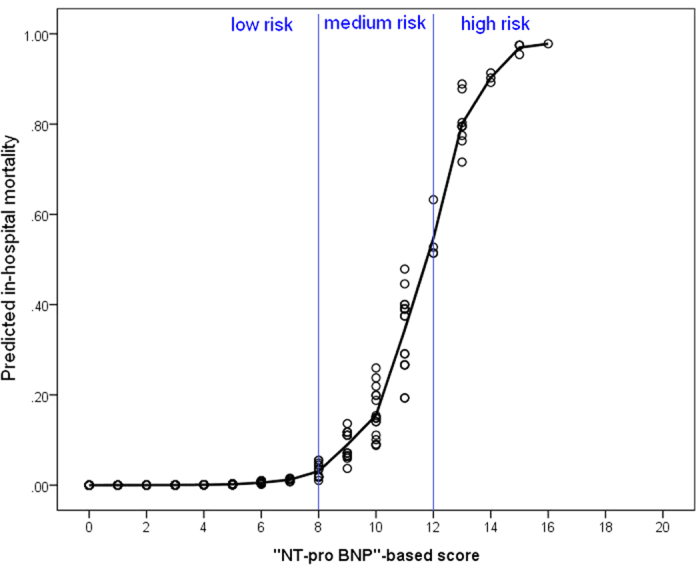
Association between the NT-pro BNP-based score and the probability of in-hospital mortality.Note: The NT-pro BNP-based score has a range of 0–20 points. According to the trend of increasing with the predicted in-hospital mortality, the NT-pro BNP-based score was categorized into low (<8 points), medium (≧8 to <12 points) and high risk (≧12 points), which represented the probability of in-hospital mortality of 0.52%, 21.70%, and 88.20%, respectively.